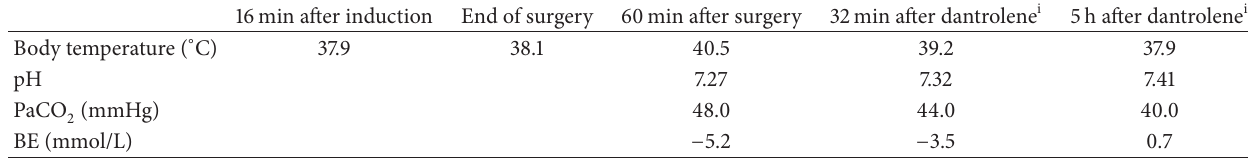
Table 1: Body temperature and arterial blood gas analysis before and after